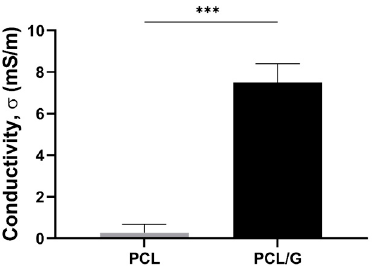
Figure 2. Electrical surface conductivity of PCL/G nanocomposites compared to pristine PCL substrate. (***) p < 0.001.